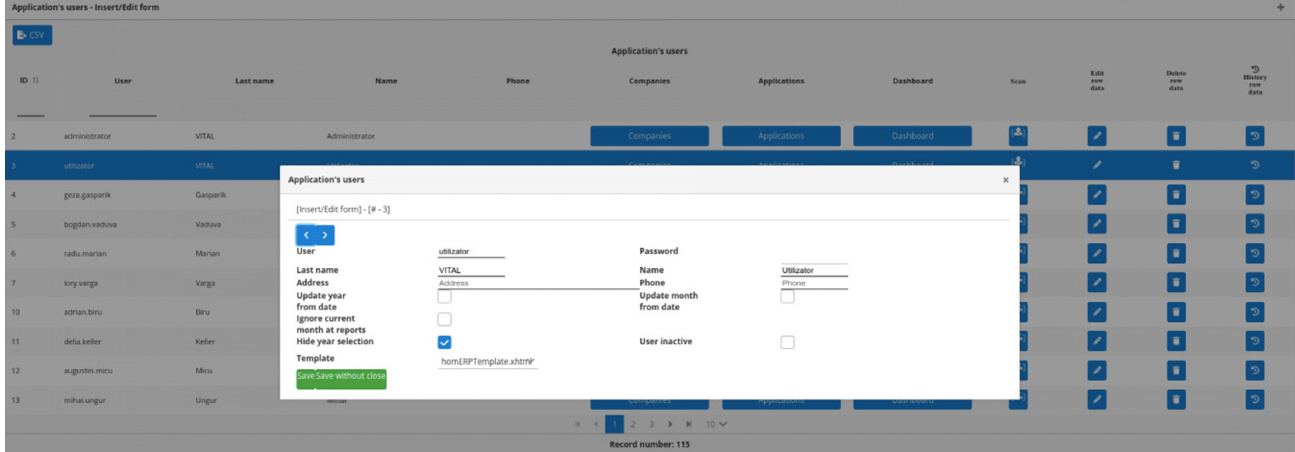
Figure 9. JavaScript/Angular 2+ “one4all” framework example—default view.